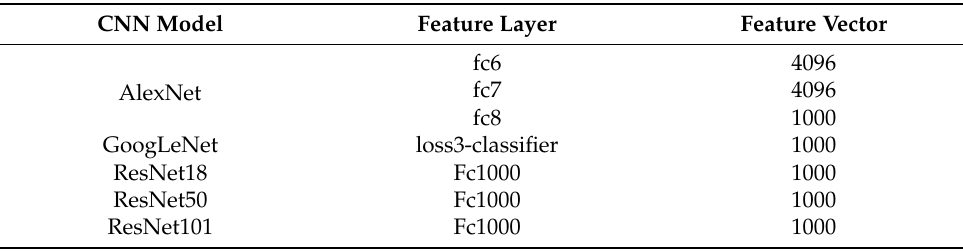
Table 1. The deep feature layer and feature vector of the studied